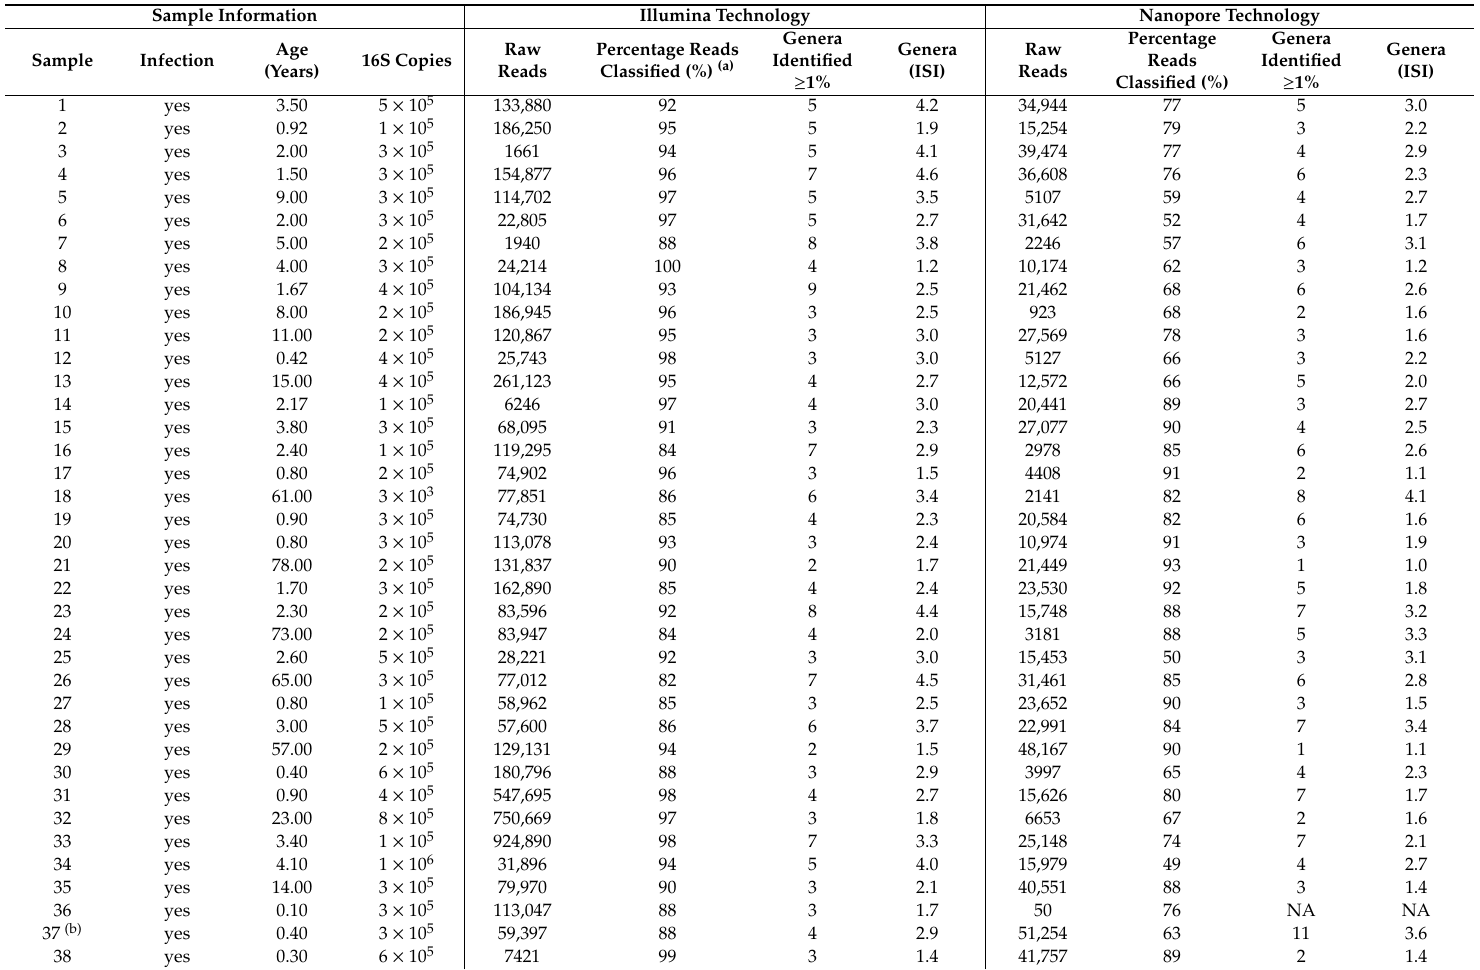
Table 1. Nose swab samples of individuals and negative controls that were sequenced using and Illumina and nanopore 16S rRNA gene sequencing technologies. (a) = a maximum of 5000 raw Illumina sequence reads were analyzed for the classification of genera. (b) = samples with read numbers below the 500 read cut-o ff . NA = not